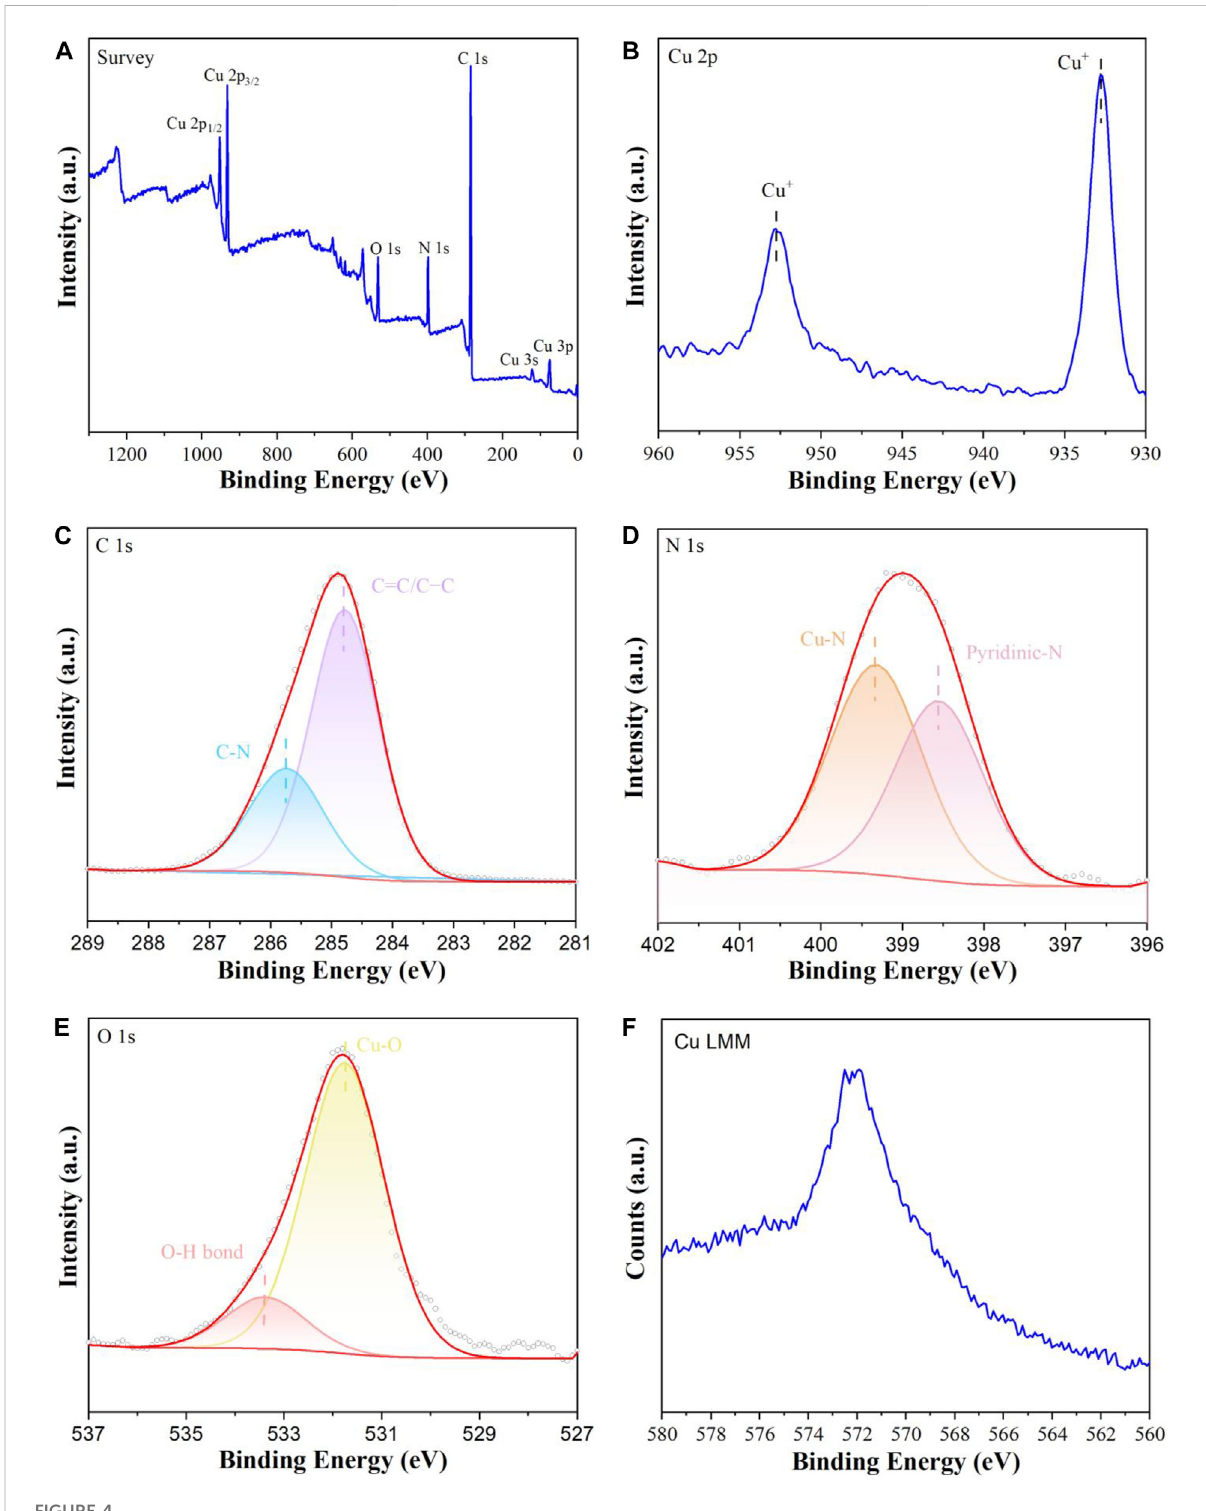
FIGURE 4 (A) XPS survey spectra of Cu I MOF , high resolution spectra of (B) Cu 3d, (C) C 1s, (D) N 1s, (E) O 1s, (F) Cu LMM Auger spectrum for in Cu I MOF